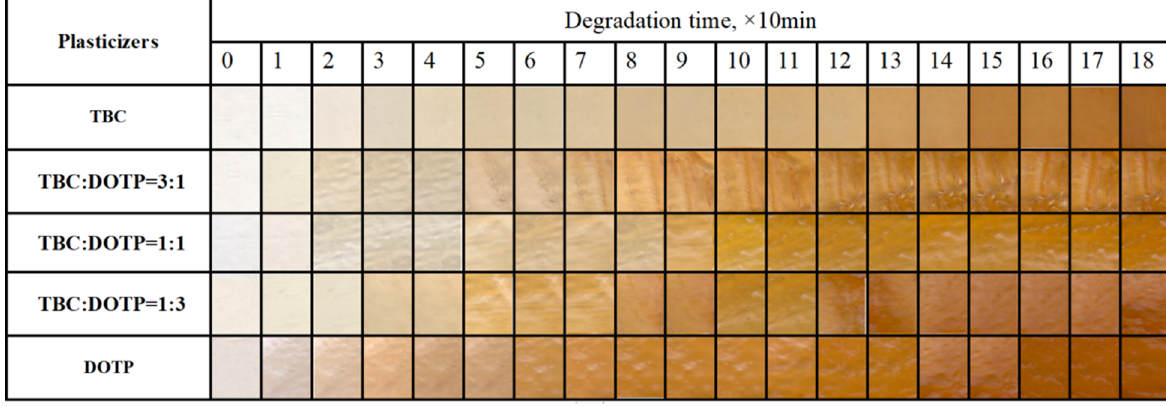
Figure 10. The thermal stability of PVC with Zn(Arg) 2 plasticized by TBC and DOTP in different proportions at 180 °C in air.